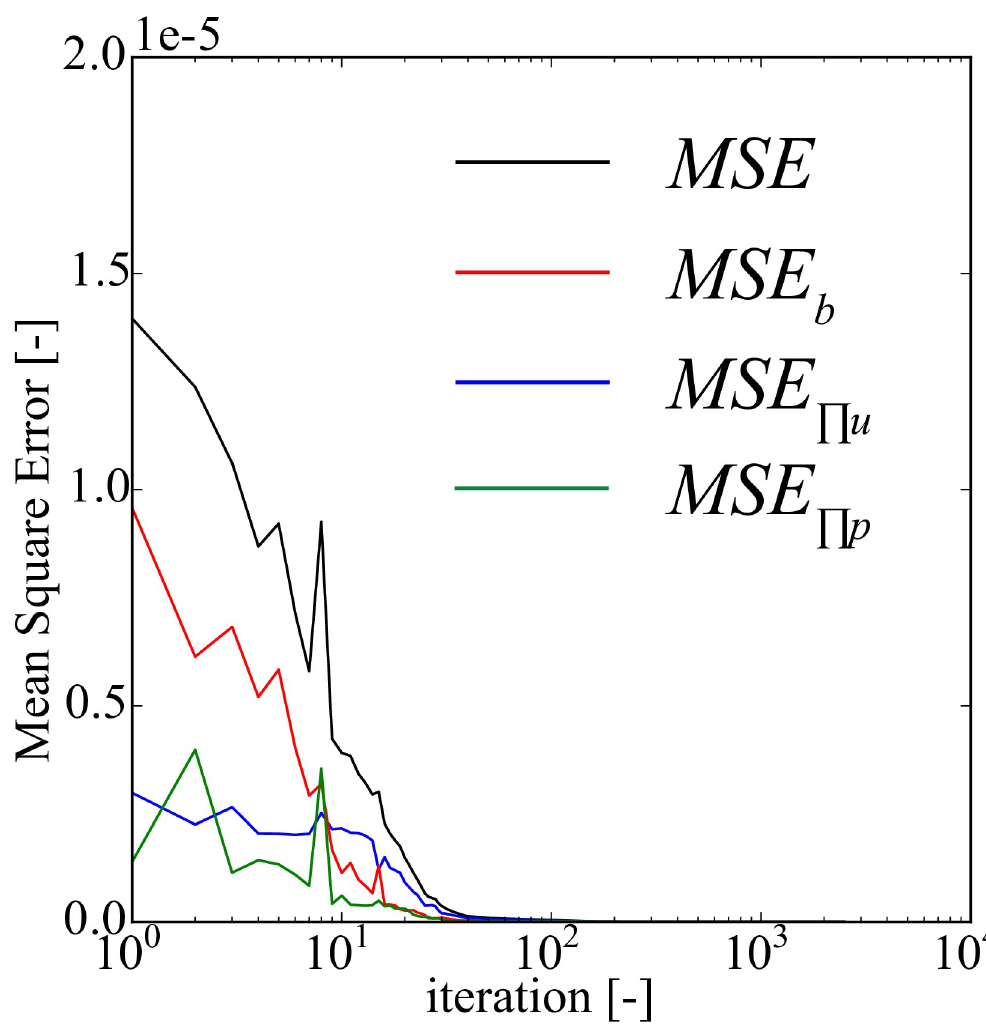
Fig 9. Biot’s equations—forward modeling: mean square training error plot. This model uses N and N P = 160. MSE , MSE b , MSE